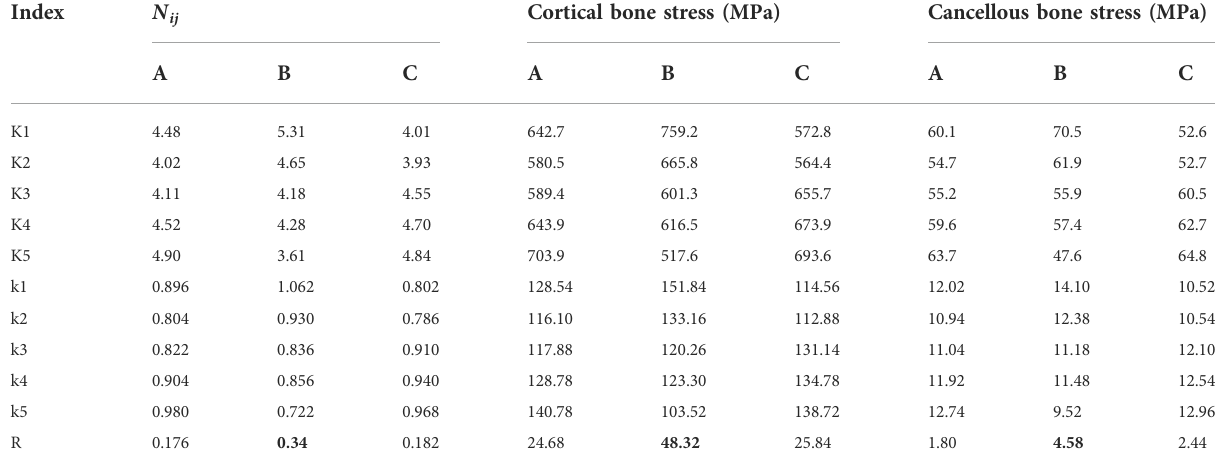
TABLE 4 Simulation results of the driver ’ s neck injury value.